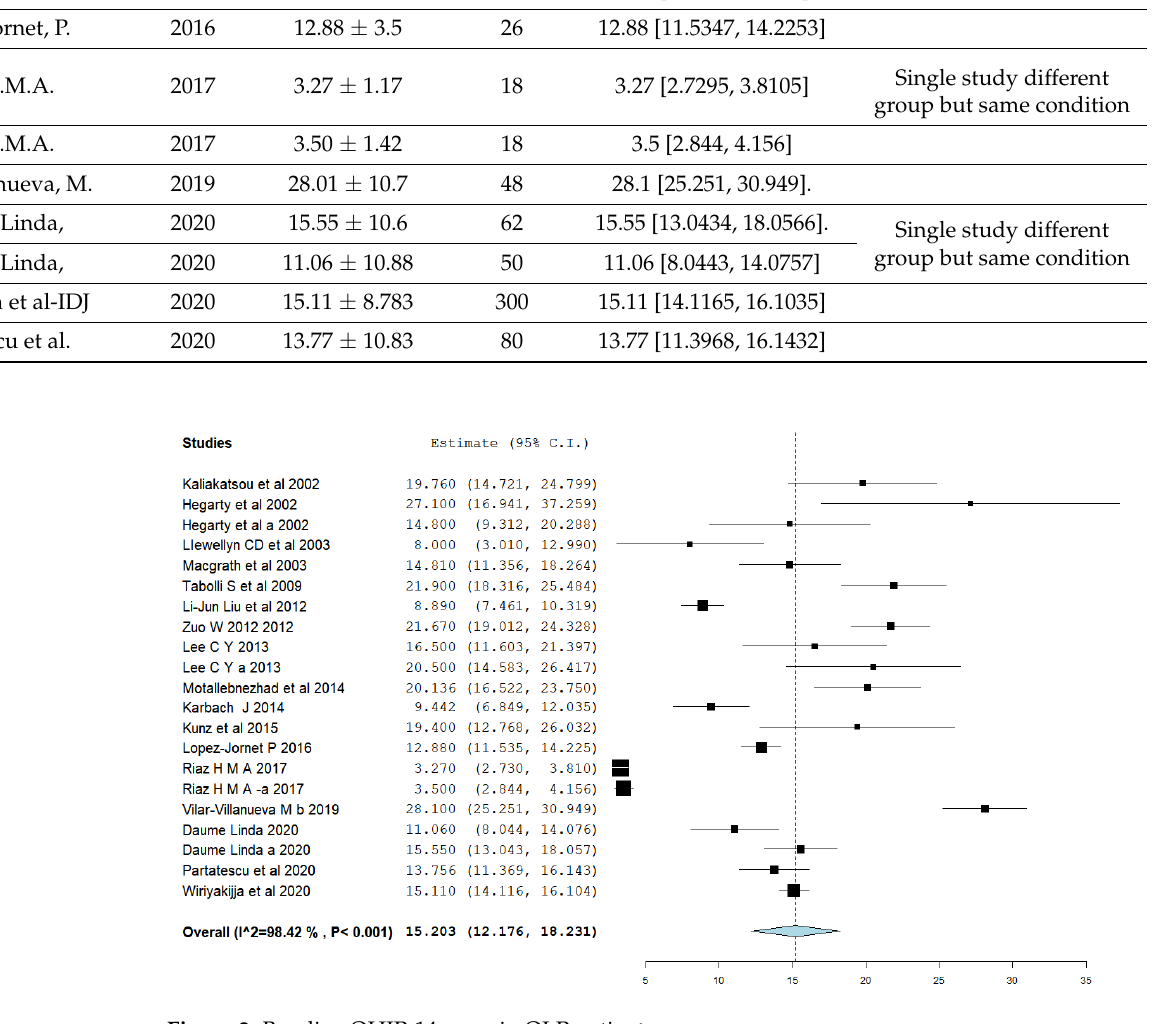
The pooled effect estimate (Baseline) (Table 4) calculated using the random-effects